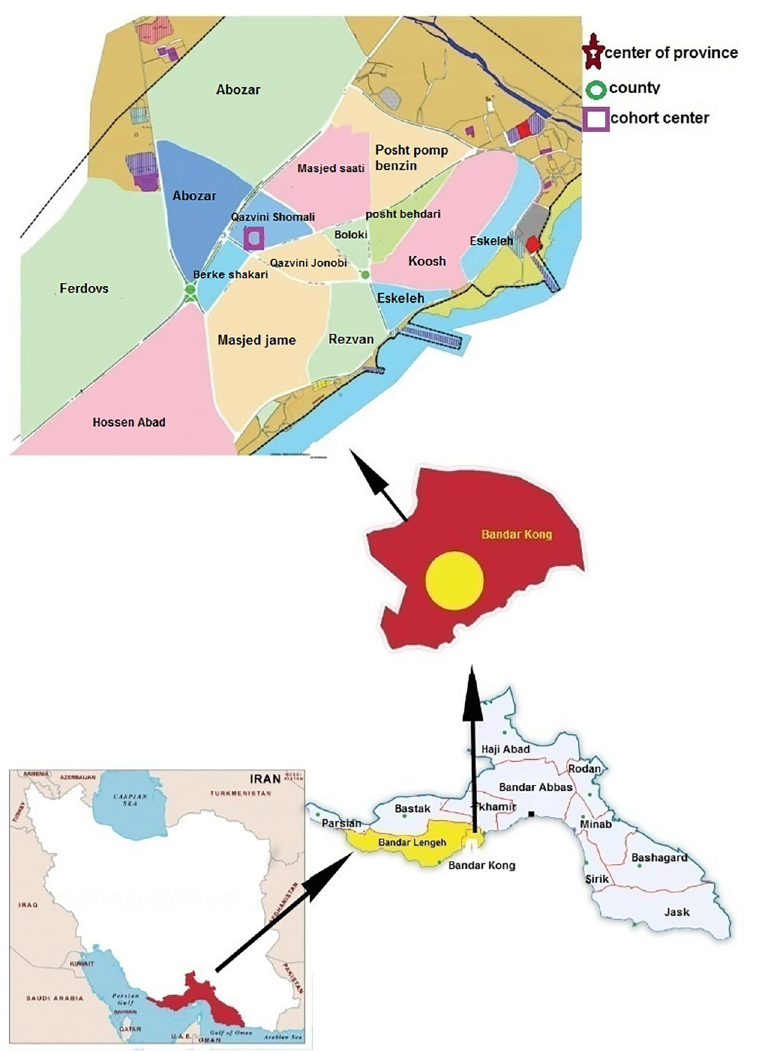
Fig 1. The map of Iran, Hormozgan province and geographic locations of Bandar Kong cohort study in southern Iran. Upper part of the figure approximately corresponds to the street map of cohort study field. [Republished from 1. Organization of Management and Planning of Hormozgan Province; https://www.ncc.gov.ir/images/docs/files; https:// www.amar.org.ir/, under a CC BY license, with permission from the Mayor of the Bandar Kong and above-mentioned body, original copyright [2006]; 2. The image was also visualized by Google Maps